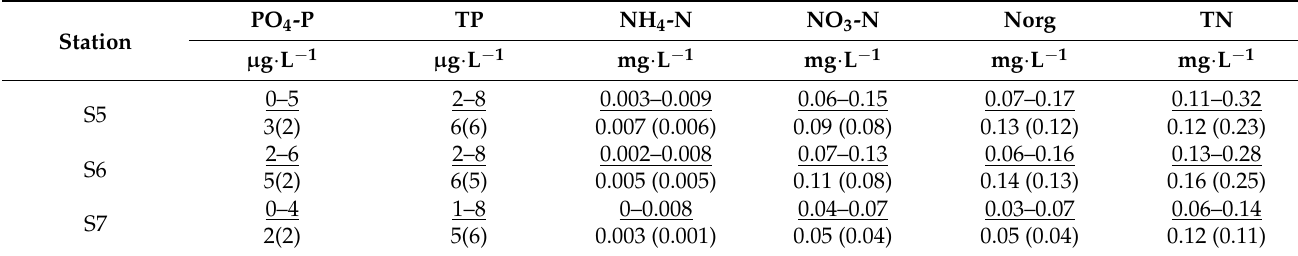
Figure 2. The distribution pattern of nutrients in Lake Gusinoe during the year. Table 3. Nutrient distribution for Lake Gusinoe waters during 2016–2018. Station